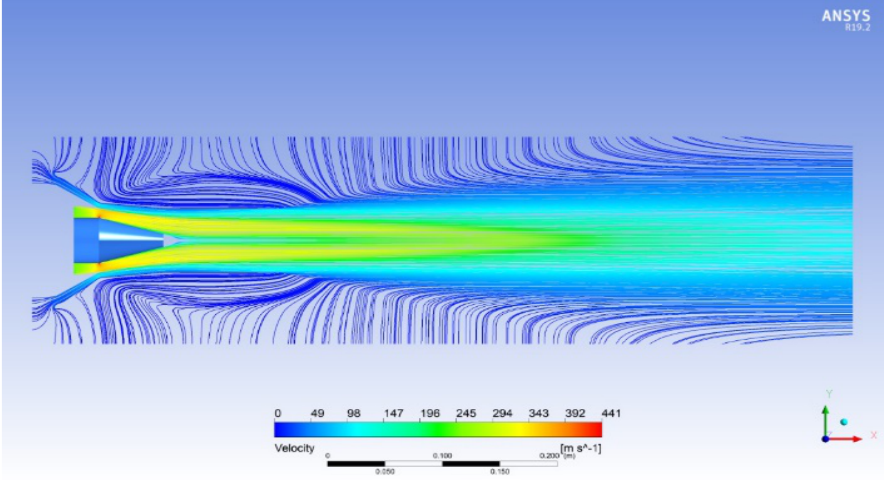
Aerospace 2023 , 10 , x FOR PEER REVIEW Figure 9. Velocity field and streamlines for the case when section 5 has a value of 5 mm. Figure 9. Velocity field and streamlines for the case when section 5 has a value of 5 mm. Figure 9. Velocity field and streamlines for the case when section 5 has a value of 5 mm.